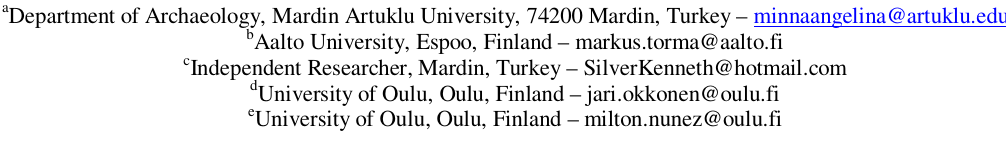
several Roman or Palmyrene sites in this region.